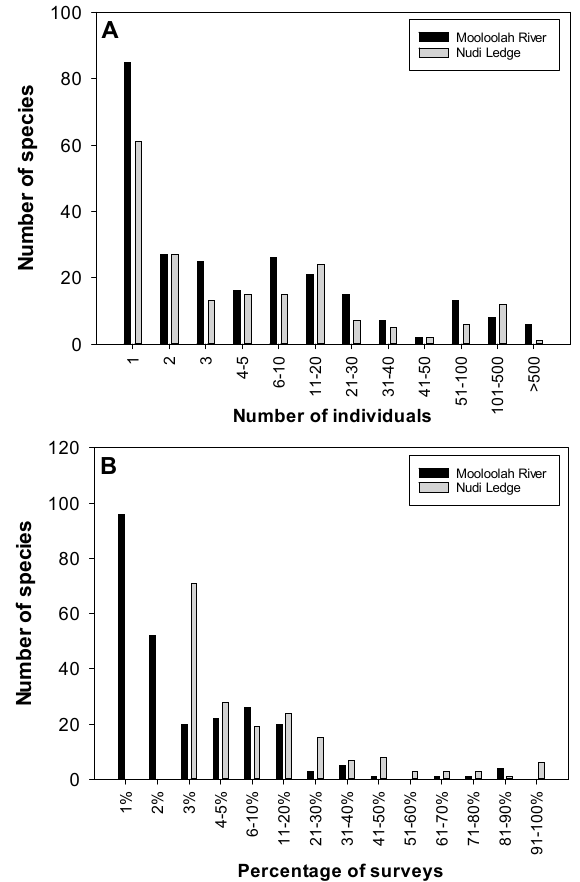
Figure 2. Distributions for species abundance ( A ), and frequency (%) of sighting ( B ) across species for heterobranch sea slugs at 2 sites on the Sunshine Coast, Qld.